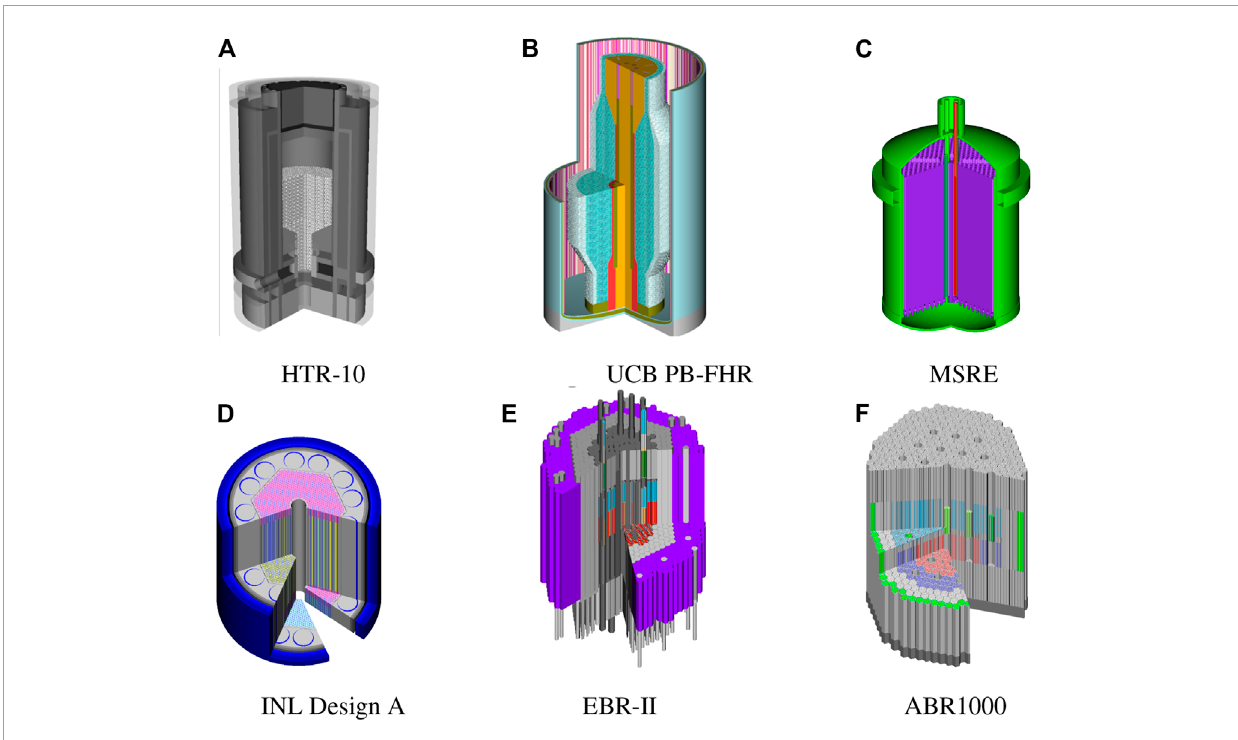
FIGURE 1 3D visualizations of the non-LWR SCALE models. (A) HTR-10, (B) UCB PB-FHR, (C) MSRE, (D) INL Design A, (E) EBR- Ⅱ and (F) ABR 1000.